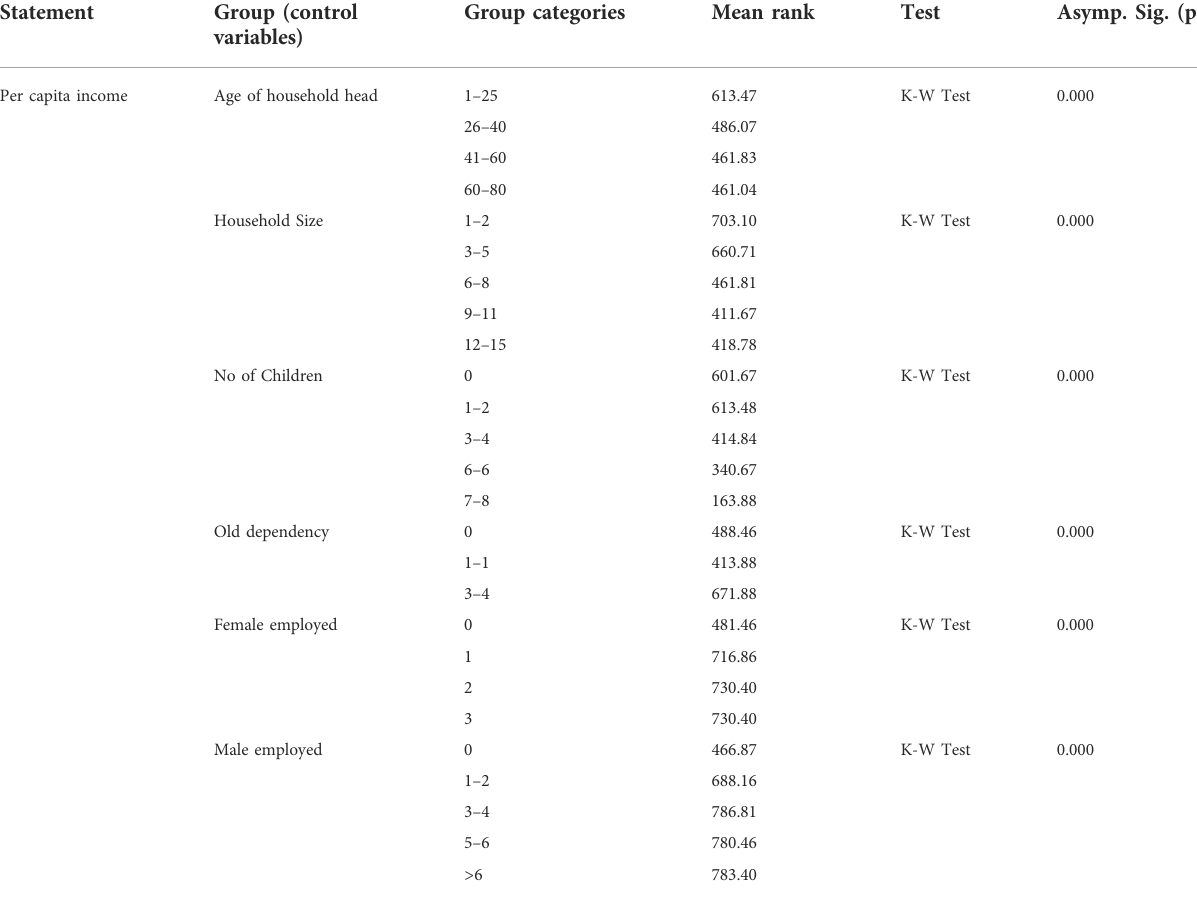
TABLE 7 Signi fi cance of age, household size, children, old age, and workers on the per capita income from the previous